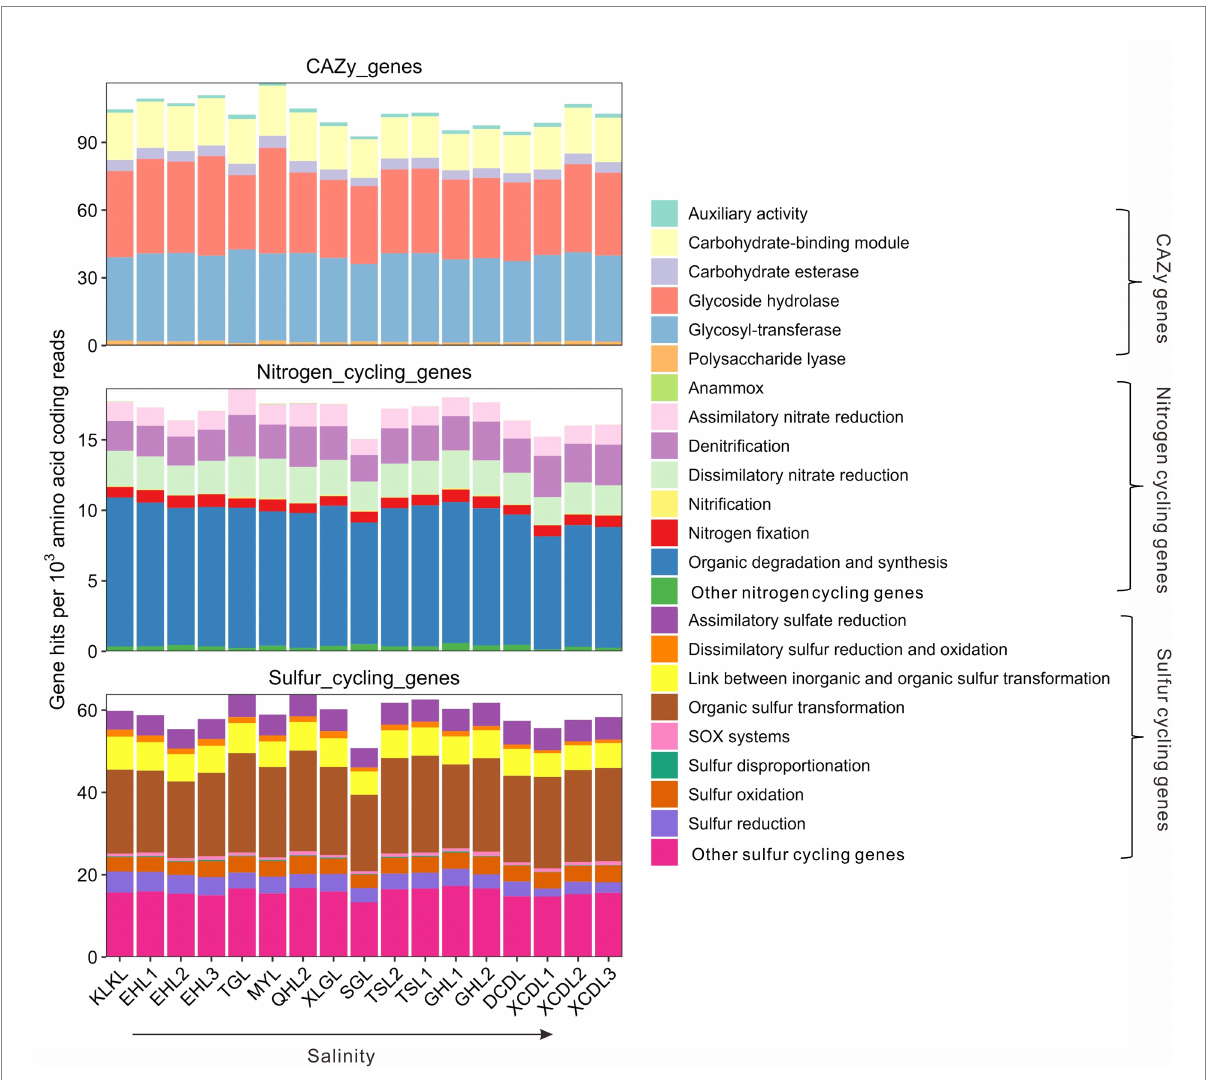
FIGURE 1 Relative abundances of the CAZy, nitrogen, and sulfur cycling gene categories in the studied lakes